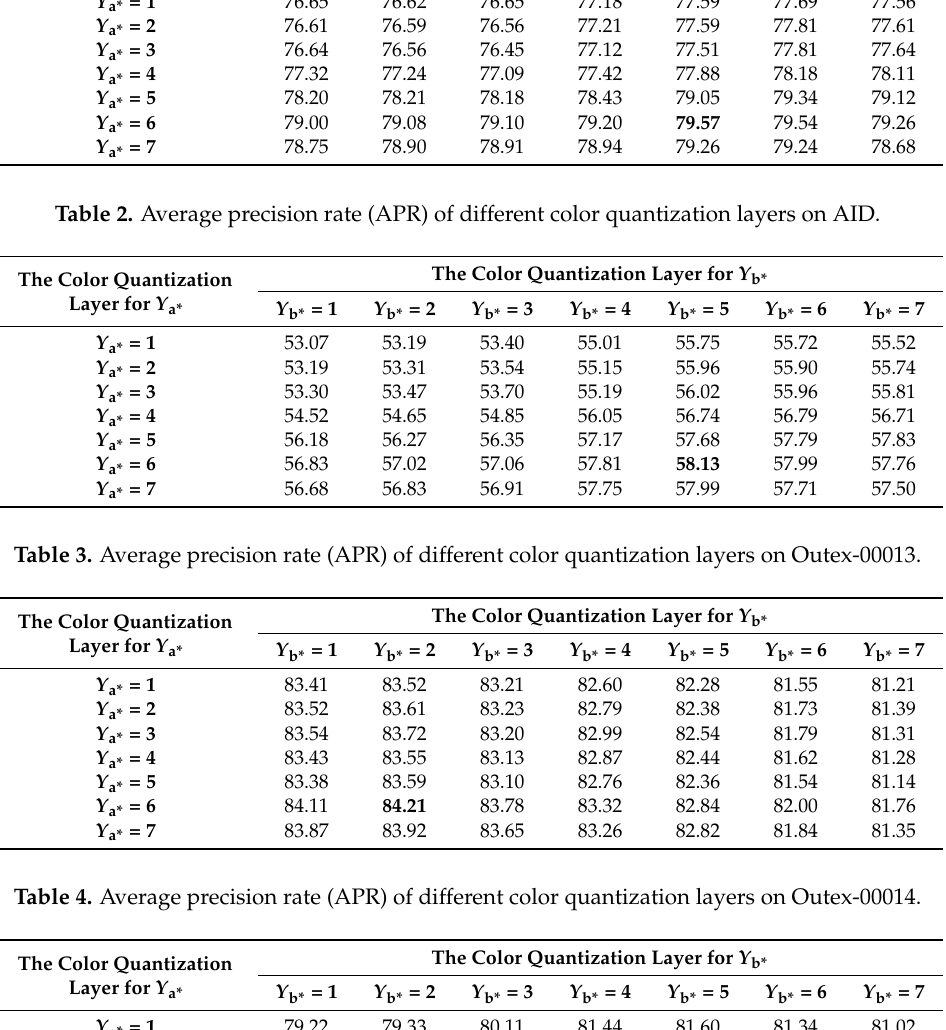
Table 1. Average precision rate (APR) of different color quantization layers on RSSCN7. The Color Quantization Layer for Y a*